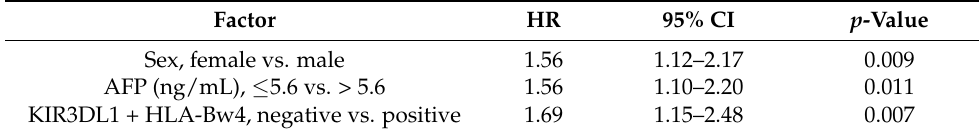
Table 4. Factors associated with HCC development in patients with cirrhosis.